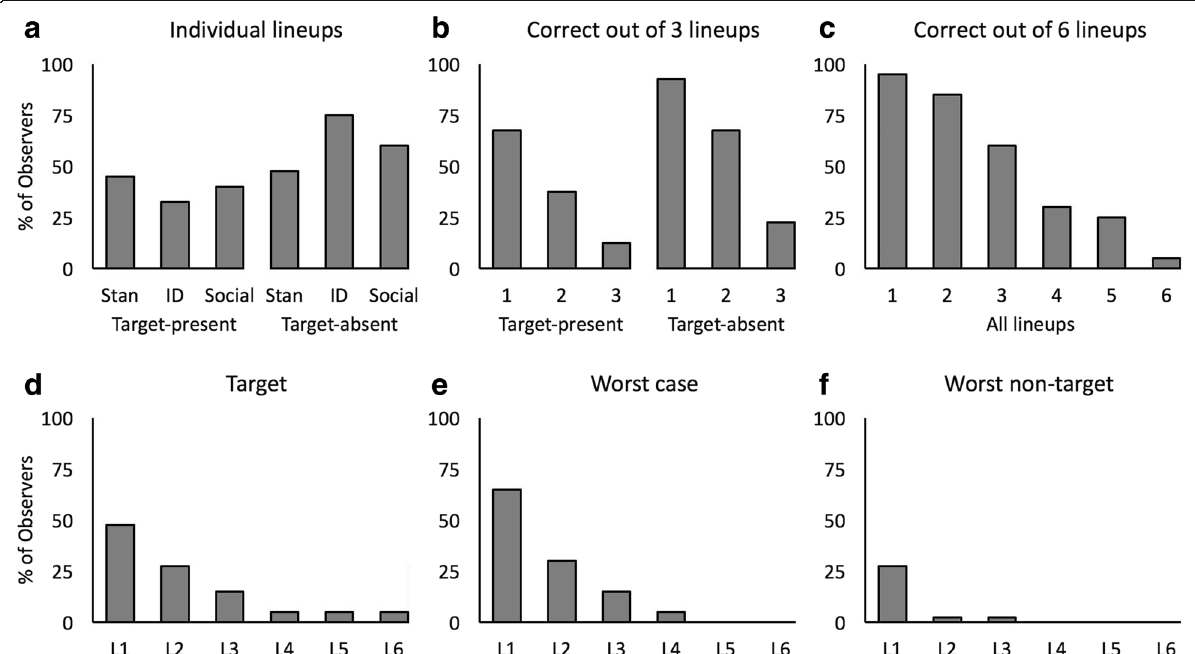
Fig. 4 Illustration of observers ’ responses in Experiment 2, showing hits for individual target-present and correct rejections for individual target- absent lineups ( a ), the number of hits and correct rejections out of three lineups ( b ), and the combined number of hits and correct rejections out of six lineups ( c ). In addition, observers ’ combined hits and correct rejections were analyzed by adhering to the order in which the six lineups were seen, for the target ( d ), the worst case analysis ( e ), and for the worst non-target ( f )